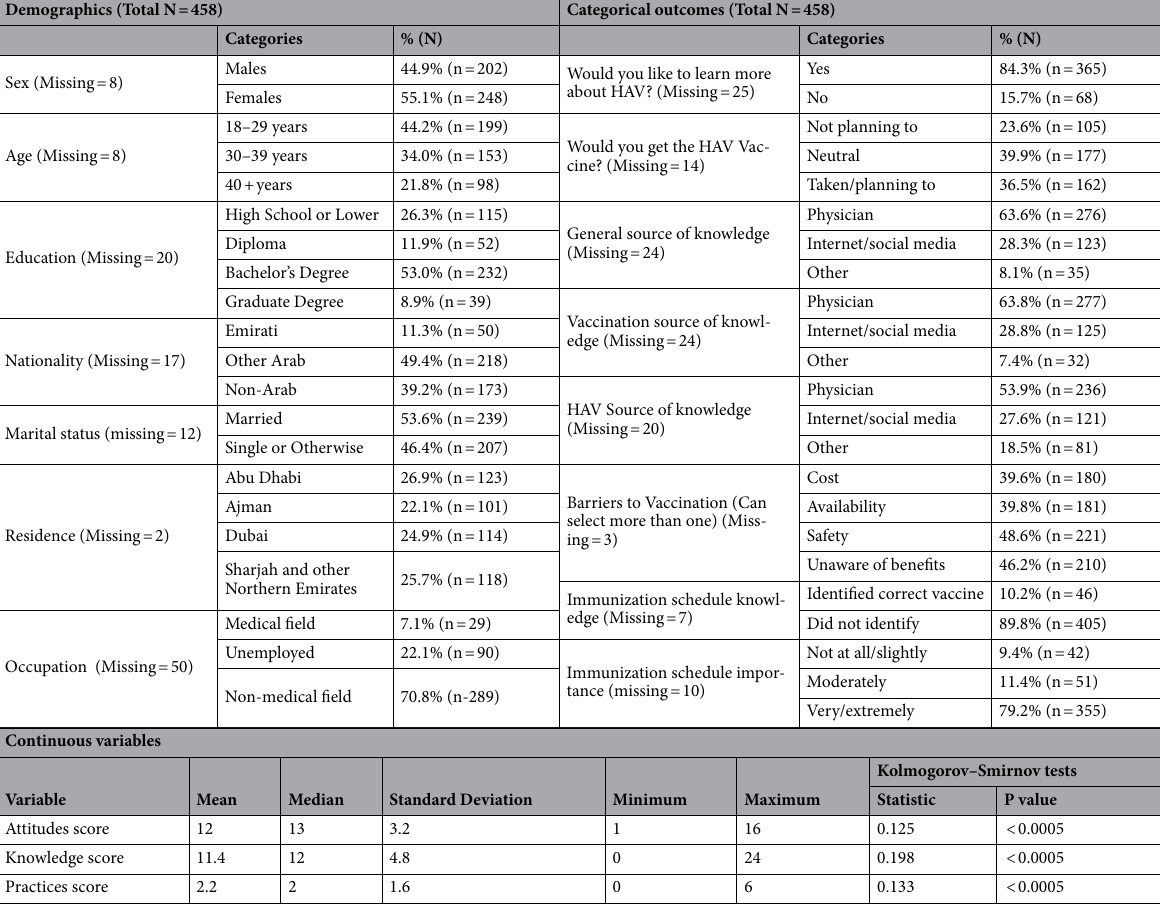
Table 1. The table summarizes the most values collected using the questionnaire. It includes all determinants and outcomes explored in the paper. Kolmogorov–Smirnov tests were also supplemented with Q–Q plots. With P < 0.05, both showed a lack of normality for all three variables.